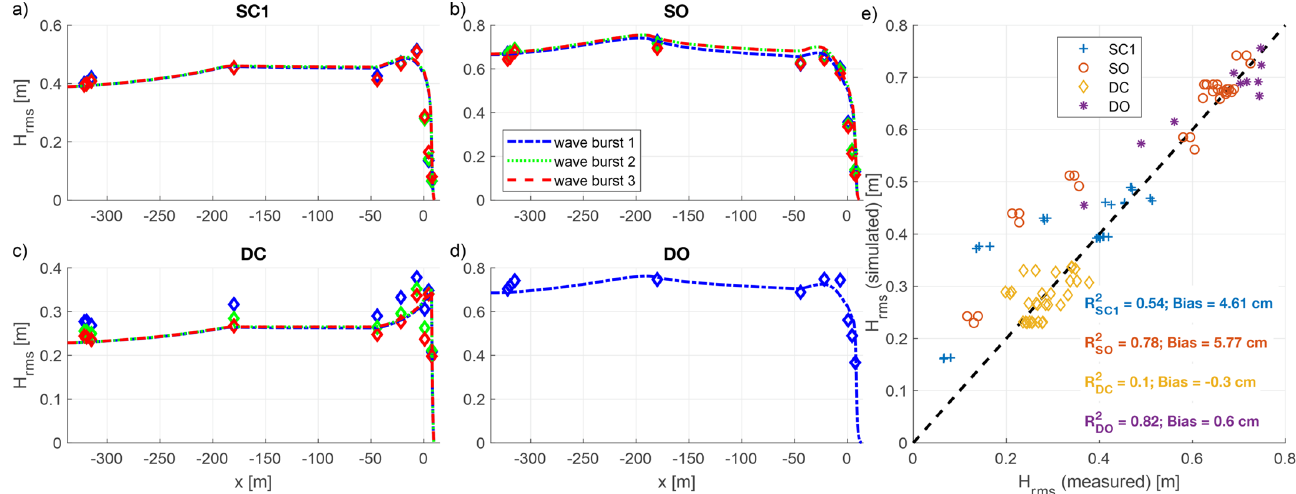
Figure 3. Comparison of computed H rms wave height ( Hmean ) with measured (upscaled) H rms,hf wave height (diamonds) for condition SC1 ( a ), SO ( b ), DC ( c ) and DO ( d ) for each wave burst except DO ( Note : Only one wave burst for DO as in the physical experiment). Further given are the scatter of measured (x-axis) and simulated (y-axis) H rms,hf wave heights including the R² and the Bias ( e ). Table 2. Comparison of wave statistics between the small-scale (adapted from [32]) and large-scale (this study) applications based on the coefficient of determination (R²) and the bias for each hydro- dynamic condition.